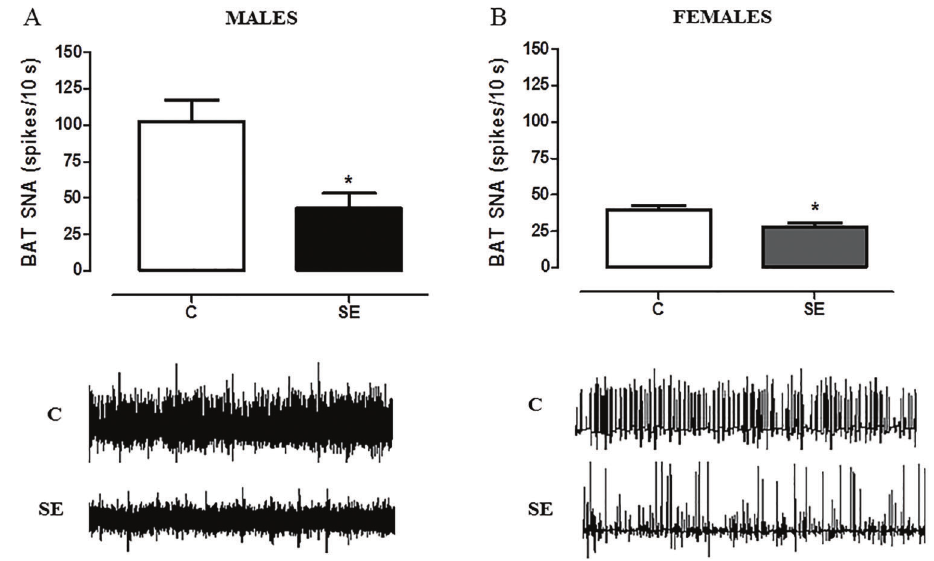
Figure 2. Long-term effects of neonatal cigarette smoke exposure on brown adipose tissue (BAT) sympathetic nerve activity (SNA). Number of spikes in 10 s at 180 postnatal days in males ( A ) and females ( B ). Representative recordings are shown at the bottom of the fi gures. C: control group; SE: smoke-exposed group. Data are reported as means ± SE for n=6. *P o 0.05 (two-way ANOVA re-examined by one-way ANOVA followed by Newman-Keuls post-hoc test).